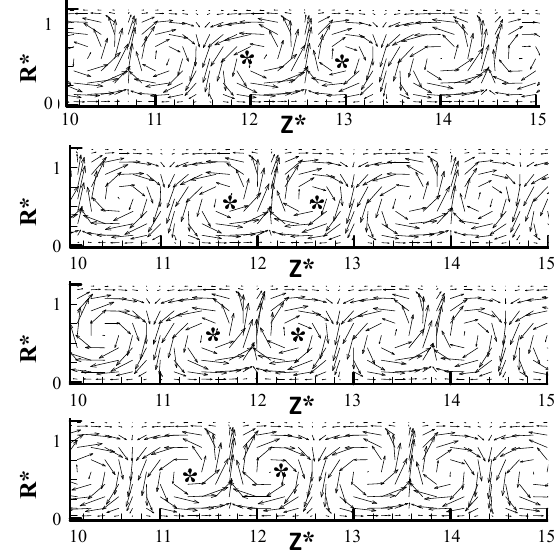
Figure 8. Instantaneous velocity fields of numerical simulation.